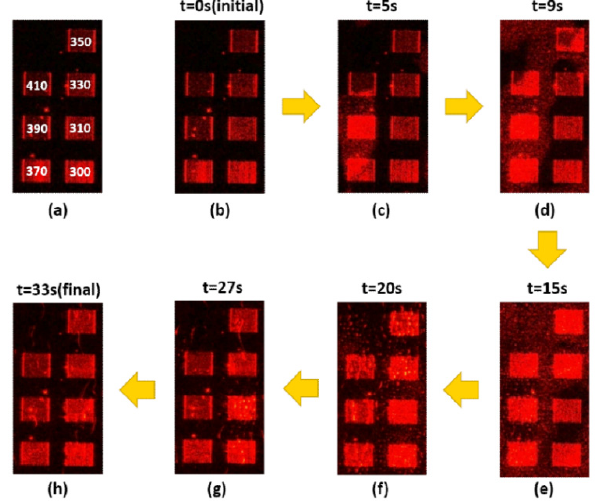
Figure 3. Sequential images from ( a ) to ( h ) illustrating transitional transmission through Al grating samples with pitches ranging from 300 nm to 410 nm. The pumping light is 532 nm. Liquid crystals are transformed from isotropic phase to nematic phase.